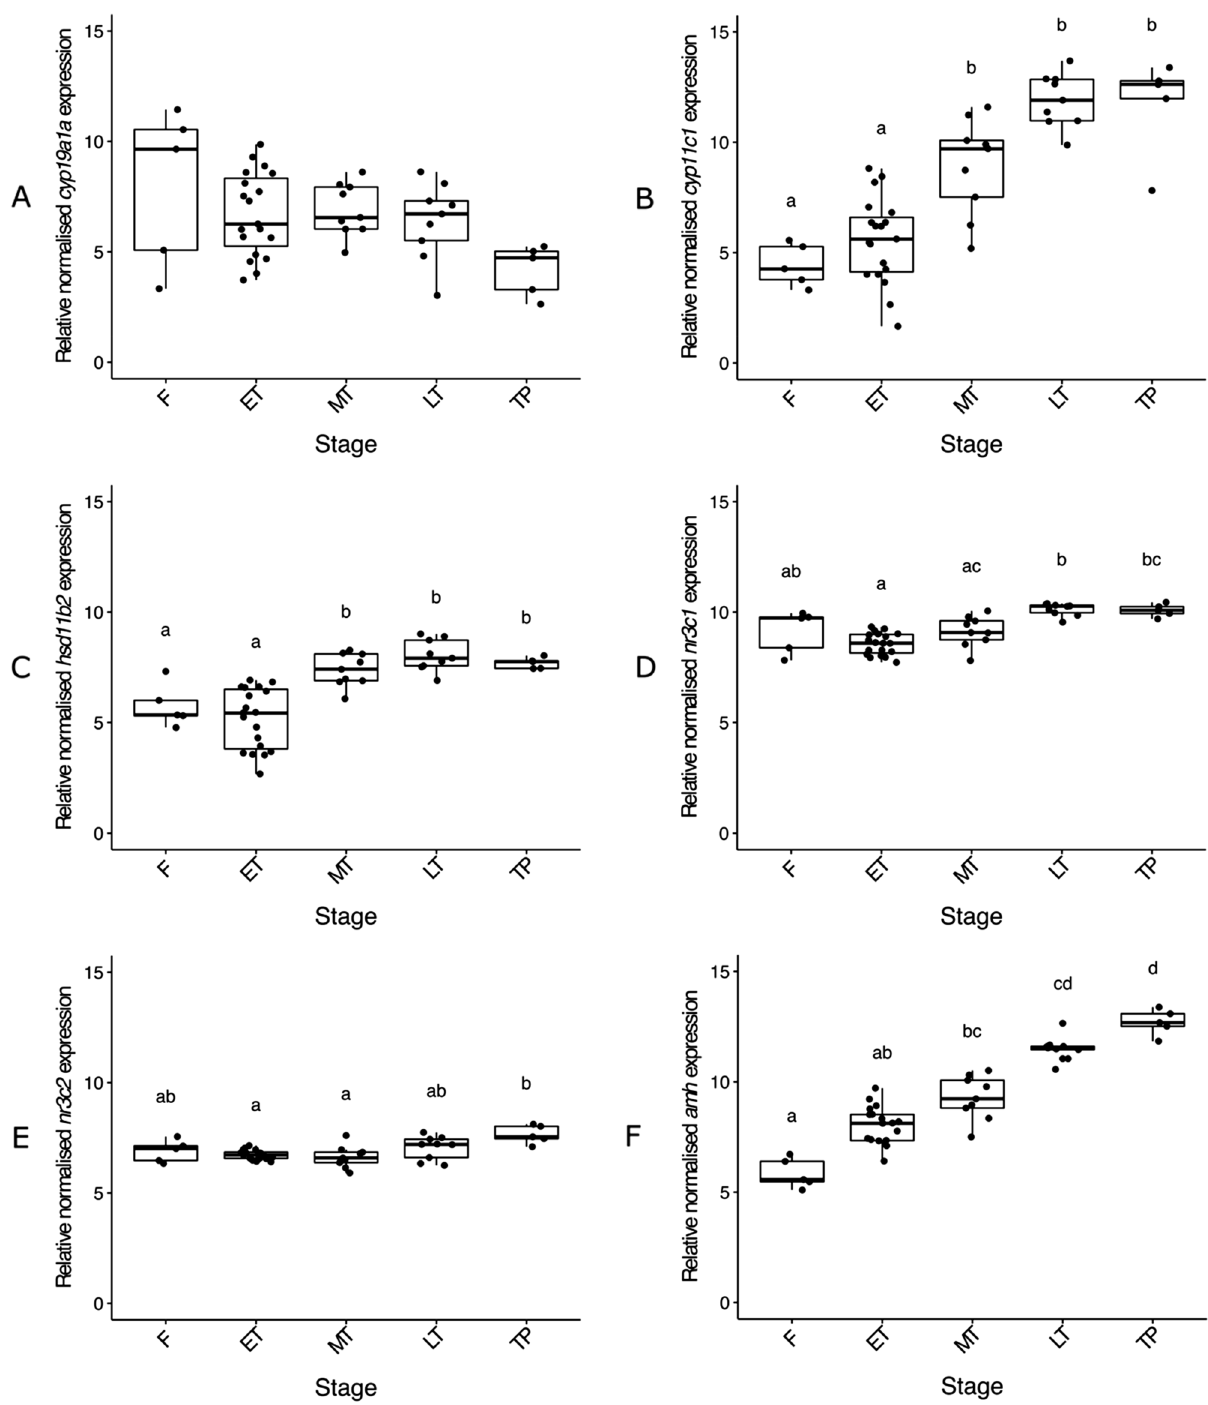
Figure 6. Relative gonadal expression of cyp19a1a ( A ), cyp11c1 ( B ), hsd11b2 ( C ), nr3c1 ( D ), nr3c2 ( E ) and amh ( F ) mRNA. Expression levels are compared among control females sampled on day 0, transitioning individuals and TP males. In the boxplots, each point represents an individual fish, the middle bold line represents the median, the edges of the box represent the upper and lower quartiles, and vertical lines represent the minimum and maximum values. Letters denote a significant difference in distribution between groups. Sample sizes: F n = 5, ET n = 19, MT n = 9, LT n = 9, TP ↑ n = 5. F control female, ET early transitioning fish, LT late transitioning fish, MT mid-transitioning fish, TP terminal phase male. ↑ Both a male used during the acclimation period of the experiment (n = 1), and males obtained through sex change of socially manipulated females (n = 4) were grouped altogether as TP males for the purpose of this